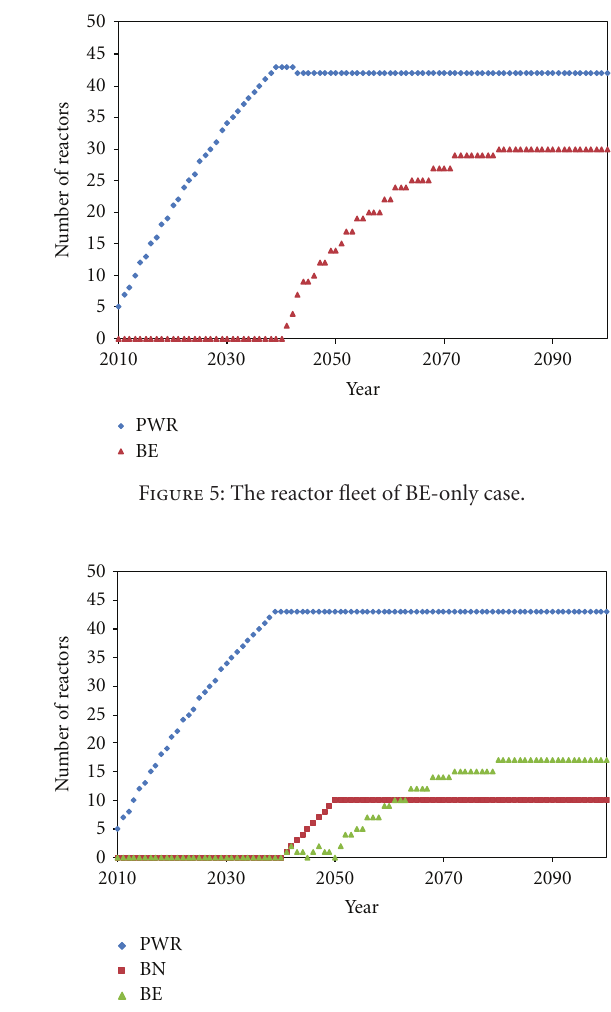
Figure 6: The reactor fleet of BN & BE